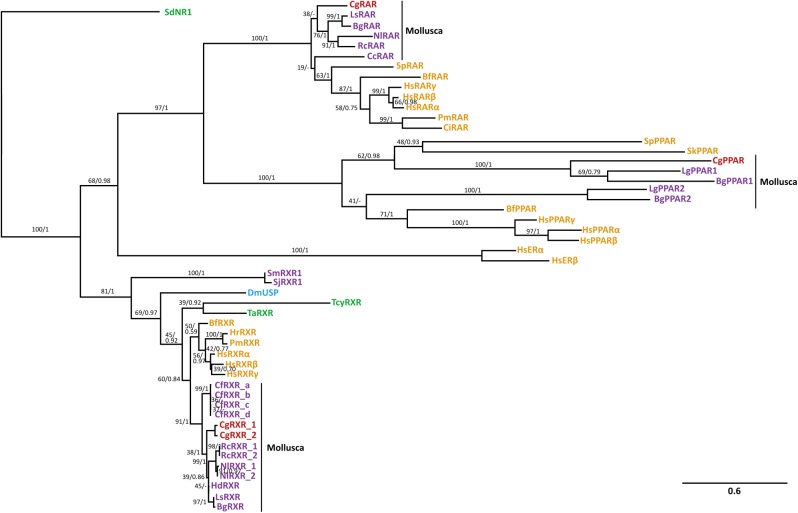
Phylogenetic tree of nuclear receptor homologs RXR, RAR and PPAR among various phyla.The alignment was constructed using the DBD plus portion of LBD and phylogenetic relationship was conducted by Maximum Likelihood and Bayesian Inference. Maximum Likelihood bootstrap support values (percentage of 1000 BS) and Bayesian posterior probabilities are provided above the nodes separated by slash. The Suberitus domuncula SdNR1 receptor was used as outgroup. Bf: Branchiostoma florida; Bg: Biomphalaria glabrata; Cc: Ciona intestinalis; Cf: Chlamys farreri; Cg: Crassostrea gigas; Dm: Drosophila melanogaster; Hd: Haliotis diversicolor; Hr: Halocynthia roretzi; Hs: Homo sapiens; Lg: Lottia gigantea; Ls: Lymnaea stagnalis; Nl: Nucella lapillus; Pm: Polyandrocarpa misakiensis; Sj: Schistosoma japonicum; Sk: Saccoglossus kowalesvski; Sm: Schistosoma mansoni; Sp: Strongylocentrotus purpuratus; Ta: Trichoplax adhearens; Rc: Reishia clavigera; Tcy: Tripedalia cystophora. ER: estrogen receptor. Red: C. gigas receptors; Orange: Deuterostomia; Purple: Lophotrochozoa; Blue: Ecdysozoa; Green: other metazoans.